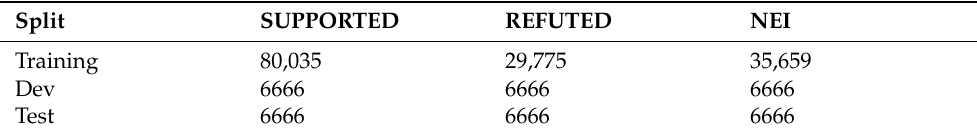
Table 2. Statistics of